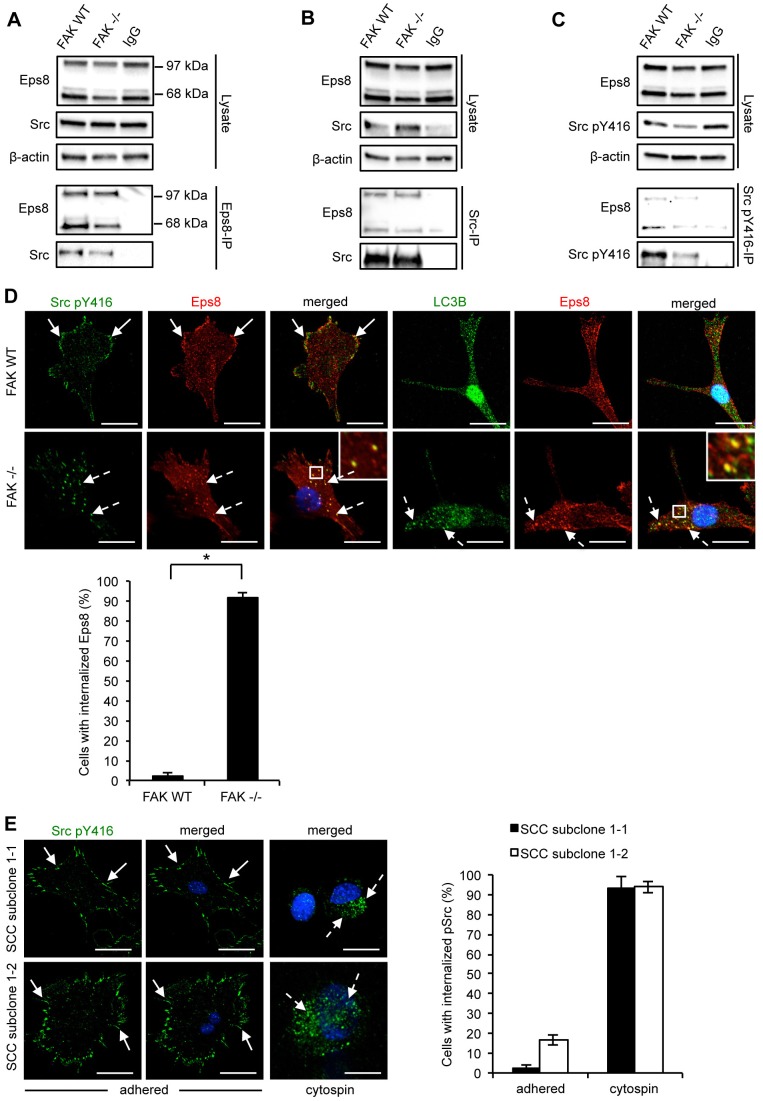
Src–Eps8 complexes localize to autophagosomes in the absence of FAK. Eps8, Src or Src pY416 were immunoprecipitated (IP) from FAK WT or FAK−/− cell lysates using (A) anti-Eps8, (B) anti-Src or (C) anti-Src pY416 antibodies followed by western blotting analysis with antibodies as indicated (lower panels). Anti-β-actin antibody was used as a loading control. (D) FAK WT and FAK−/− cells were grown on glass coverslips, fixed and stained using anti-Src pY416 and anti-Eps8 (left hand panels) or anti-LC3B and anti-Eps8 (right hand panels). Solid arrows indicate focal adhesions (upper panels) and dashed arrows indicate internalized active Src or Eps8 (lower panels). Scale bars: 20 µm. Insets show a magnified view of the boxed area. A quantification is shown below the images. Results are mean±s.d. *P<0.001 (Student's t-test). (E) SCC subclone 1-1 and subclone 1-2 cells were suspended in PBS for 1 h and cytospins were prepared and stained for Src pY416 and DAPI. Solid arrows indicate focal adhesions (upper panels) and dashed arrows indicate internalized active Src or Eps8 (lower panels). Results are mean±s.d. The quantifications are representative of 100 cells from three independent experiments. Scale bars: 20 µm.